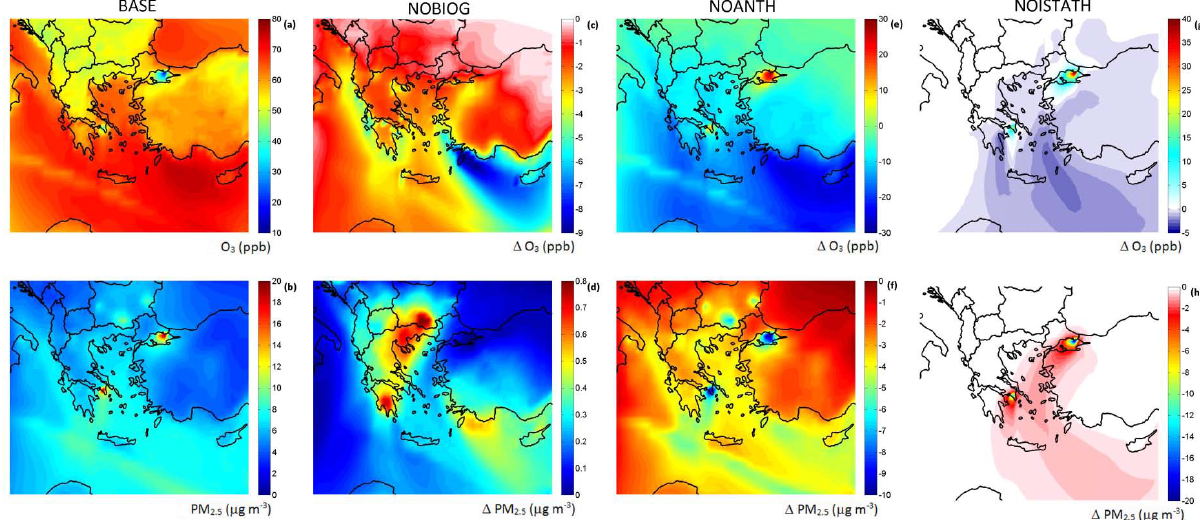
Fig. 3. Summertime (July 2008) surface O 3 (a, c, e, g) and PM 2 . 5 (b, d, f, h) levels calculated from the base case scenario (Base: a, b ) and the absolute differences of scenarios “NoBiog” (c, d) , “NoAnth” (e, f) and “NoIstAth” (g, h) from the “Base”, averaged for the month of the simulation. Units are ppbv for O 3 and 1 O 3 and µgm − 3 for PM 2 . 5 and 1 PM 2 . 5